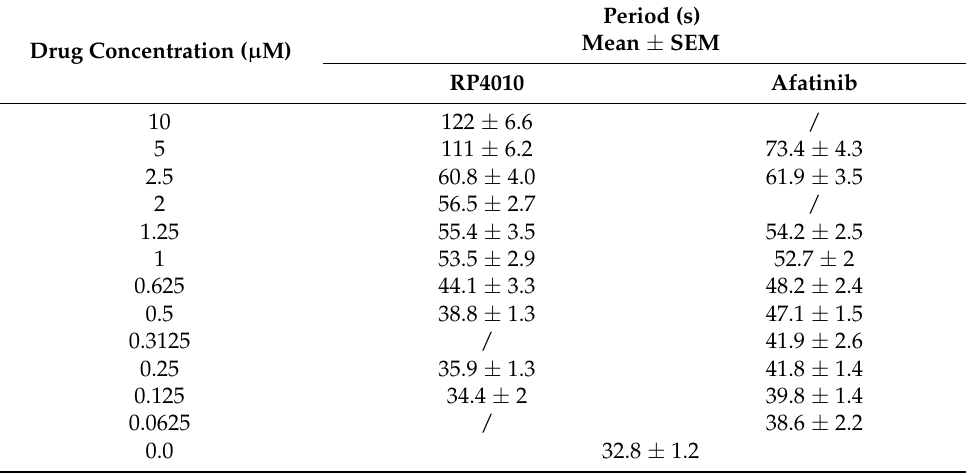
Table 1. Dose-dependent drug effects on intracellular Ca 2+ oscillations (experimental data).